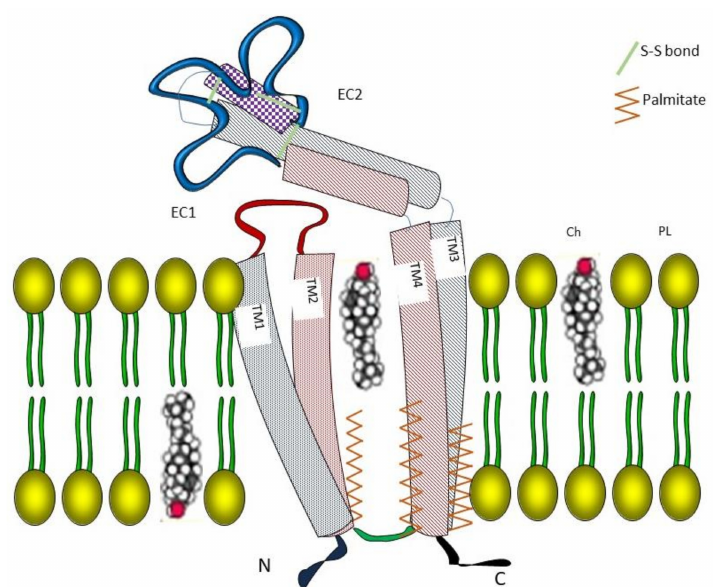
Figure 2. Schematic representation of Tspan8 in membrane. The transmembrane (TM) domains inserted in the phospholipid bilayer are palmitoylated with a cholesterol molecule in between these domains (by analogy with CD81 structure [13]). Among the two extracellular (EC) regions, the larger region contains six cysteines involved in disulfide bonds. EC1 and EC2 = extracellular domains 1 and 2; Ch = cholesterol; and PL =